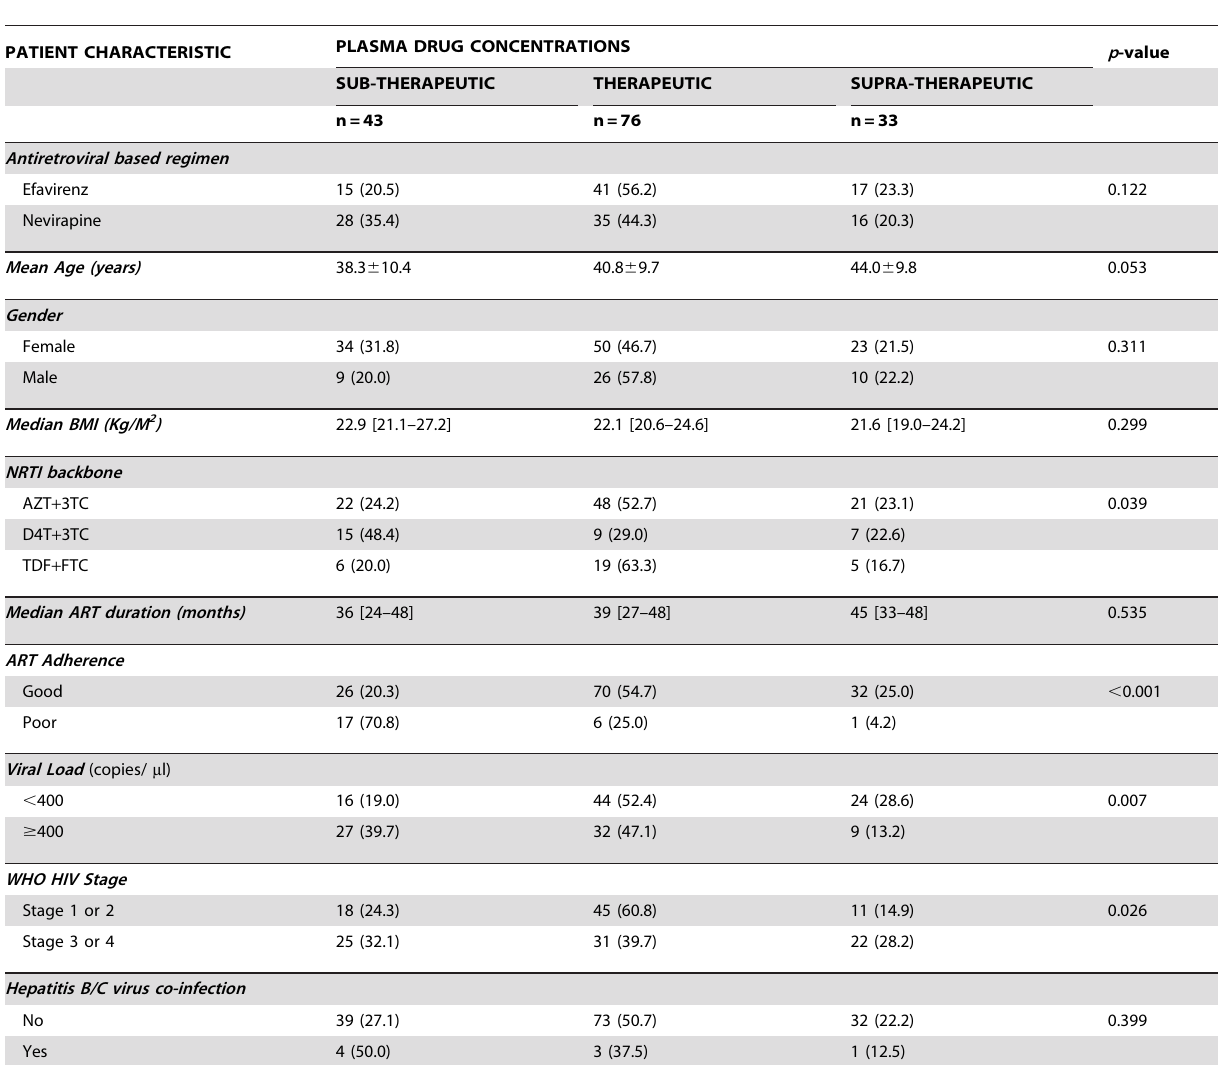
Table 2. Comparison of distribution of patients’ characteristics within plasma antiretroviral drug concentrations (sub-therapeutic, therapeutic and supra-therapeutic) among 152 participants.